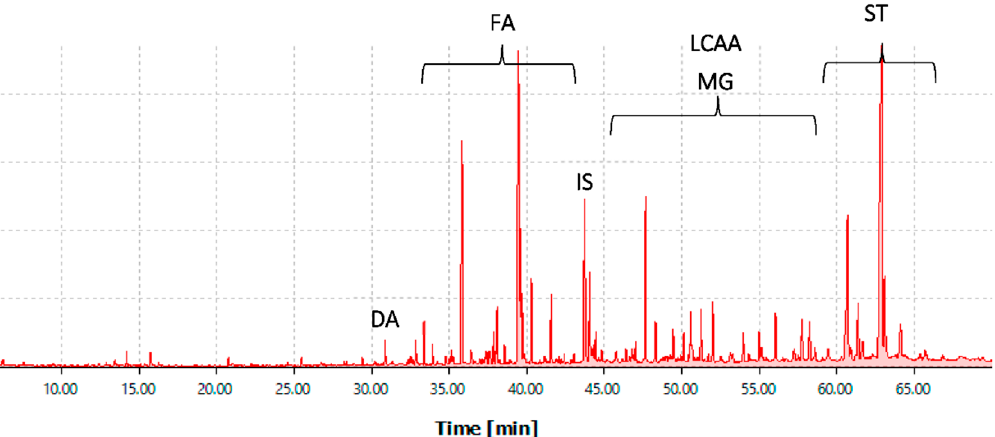
Figure 1. GC–MS chromatogram of trimethylsilylated DCM extract of Opuntia ficus-indica harvested in Kabylia area. Abbreviations: DA, dicarboxylic acids; FA, fatty acids; IS, internal standard; LCAA, long chain aliphatic alcohols; MG, monoglycerides; ST,